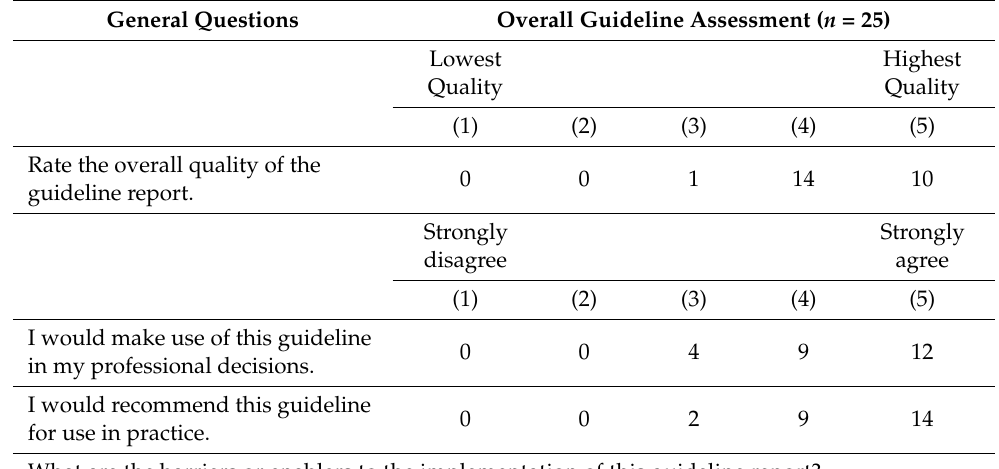
Table 2. Responses to four items on the professional consultation survey.